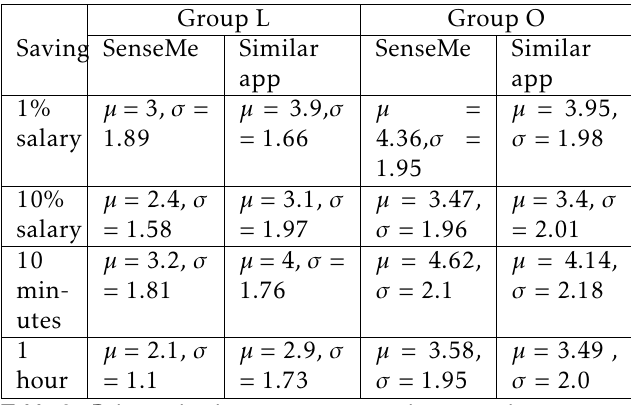
Figure 9. Anova for usage of SenseMe and a similar app developed by a major tech company and both saved the subjects’ different amounts of money and time